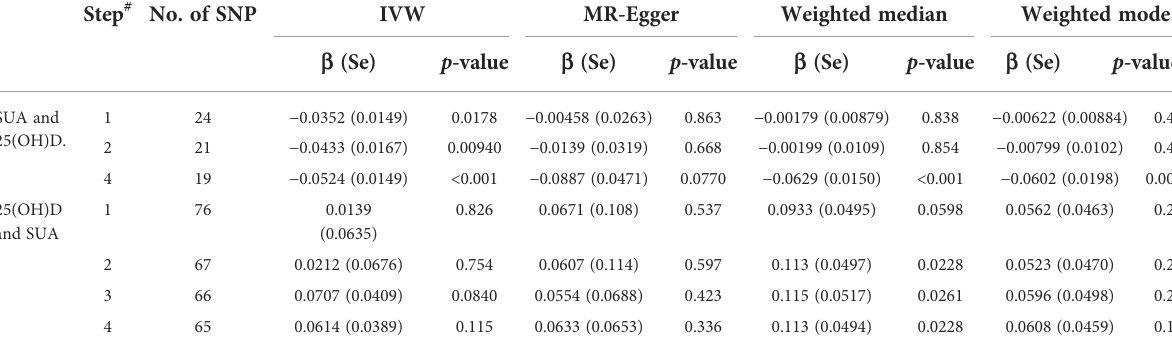
TABLE 1 MR estimates from different methods of assessing the causal association between SUA on 25(OH)D step by step. Step # No. of SNP IVW